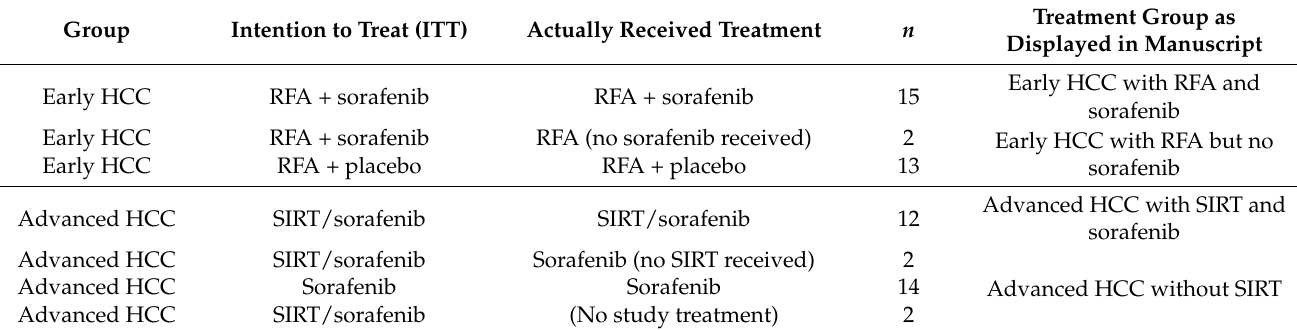
Table 3. Received treatments in patients with an early HCC and an advanced HCC within the SORAMIC trial. HCC